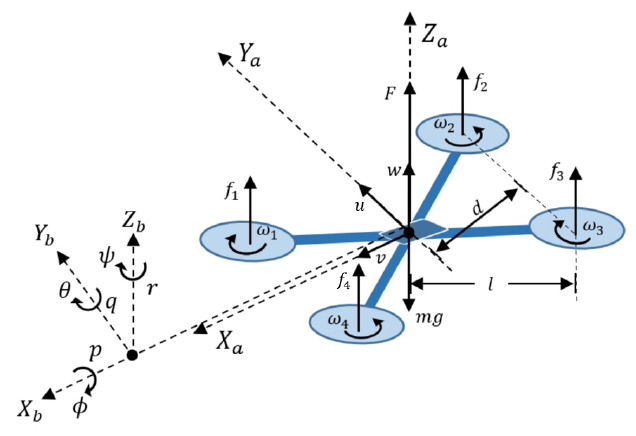
Figure 3. Free-body diagram of a